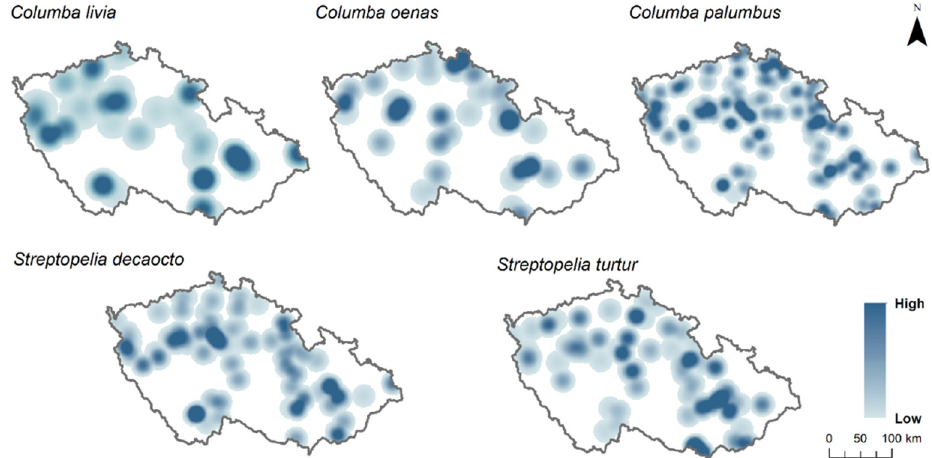
Figure 1. Five Columbidae species distribution in the Czech Republic with Kernel density interpolation. The darker blue colour represents a high density of points, where species were present during the survey; light blue colour represents a low density of points, where species were present during the survey; white areas are where census transects are missing. Distribution of five species: Feral pigeon ( Columba livia forma domestica ), stock dove ( Columba oenas ), wood pigeon ( Columba palumbus ), Eurasian collared dove ( Streptopelia decaocto ), and European turtle dove ( Streptopelia turtur